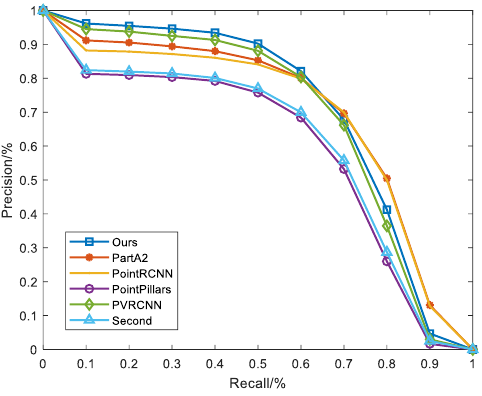
Figure 7. Precision – recall curve. Figure 7. Precision–recall Table 3. Results of 3D detection on the KITTI val split with rain noise before training for the Car category.